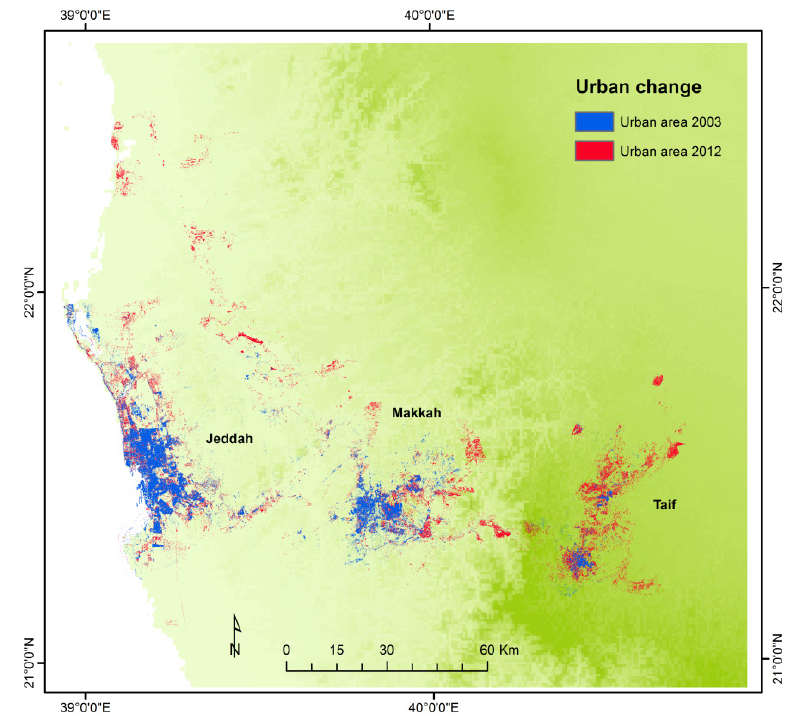
Figure 5. Urban expansion in Makkah.